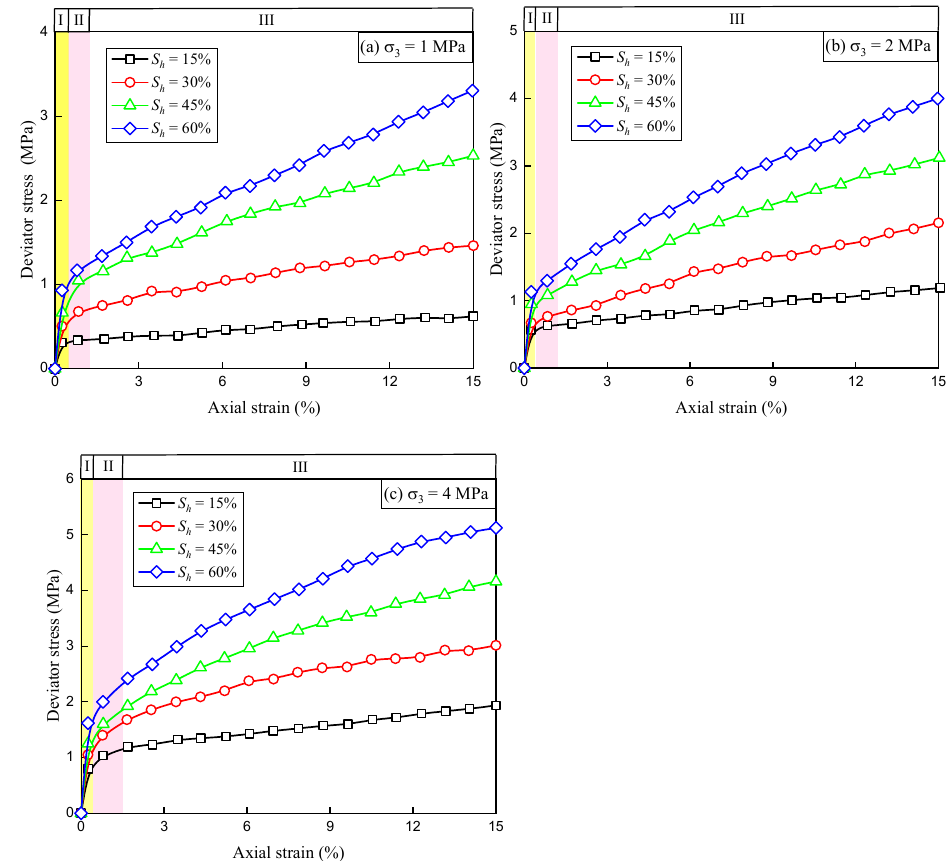
Figure 3. Stress-strain relationship of samples under various conditions (based on [30]): (a) σ 3 = 1 MPa; (b) σ 3 = 2 MPa; (c) σ 3 = 4 MPa.